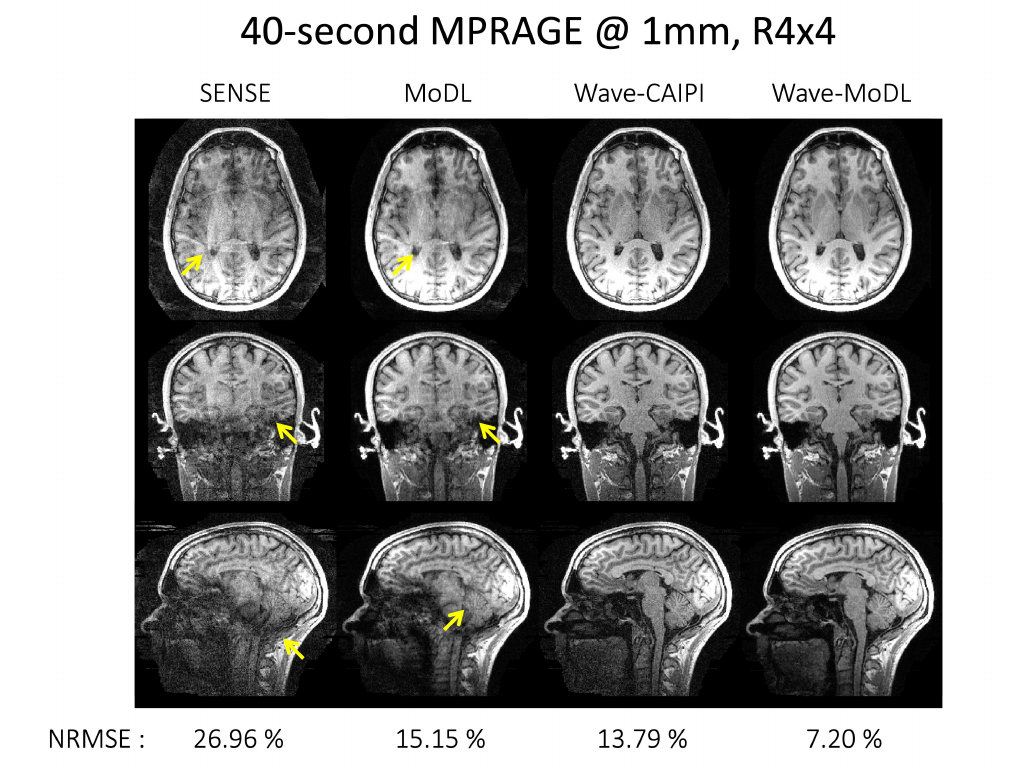
Figure 3. 40 s 1 mm MPRAGE image reconstruction at R = 4 × 4. The arrows point to the folding artifacts and noise